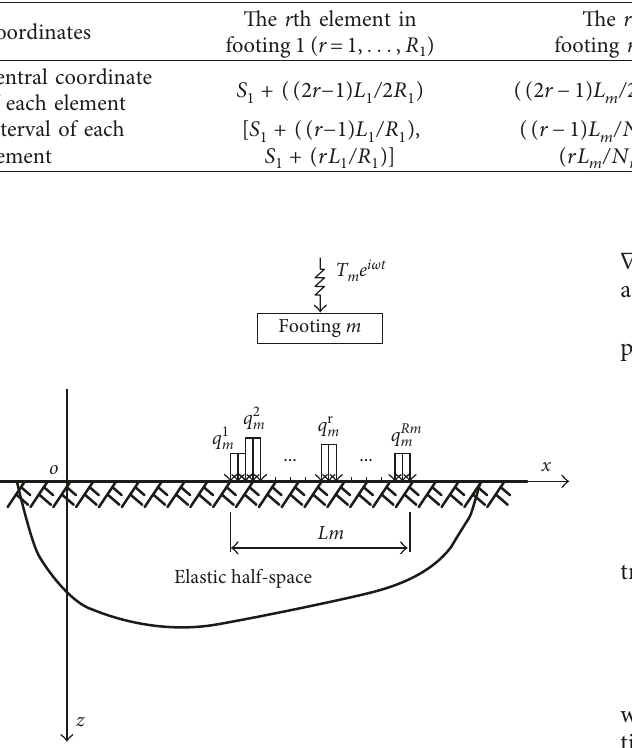
tional wave ( P wave) velocity, and V wave ( S wave) velocity. Ue iωt and w We iωt . (cid:31) (cid:31) z u/ z x z w/ z z and (cid:31) ( ) + ( )